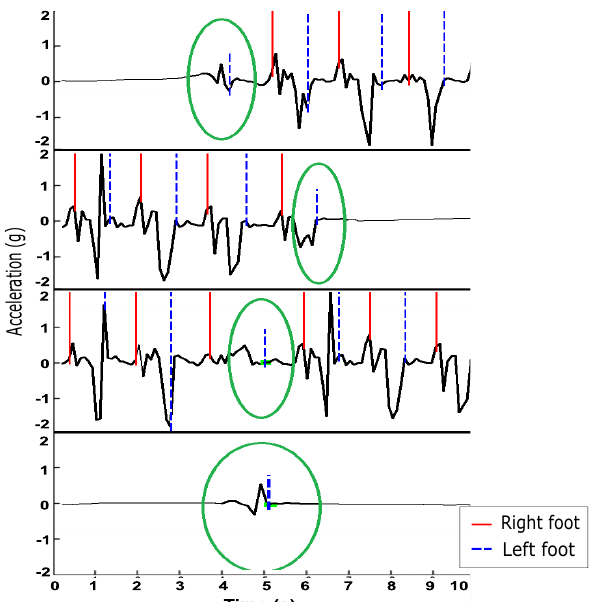
Figure 3. A sample from the ankle accelerometer signal associated with several ground truth steps in the regular gait activity. The peak in acceleration between each right step (red solid line) and left step (blue dashed line) is indicative of the motion of the left